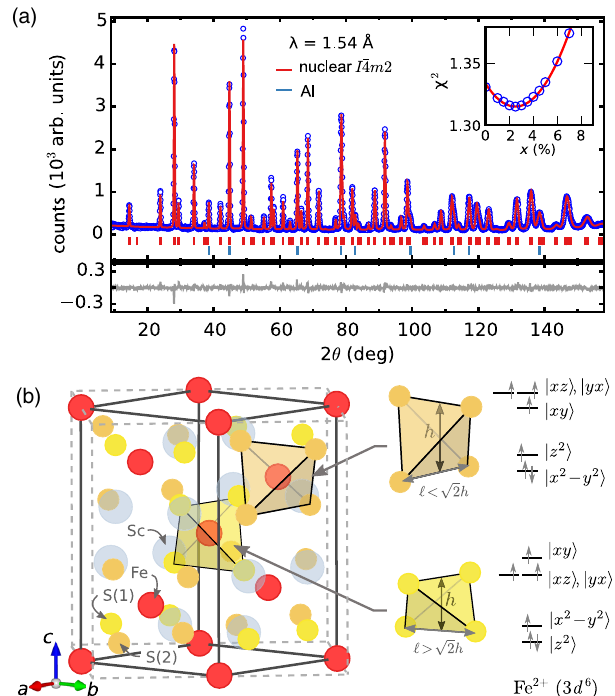
FIG. 4. (a) Neutron powder diffraction pattern for FeSc 2 S 4 measured on BT-1 at 20 K. Open symbols are observed intensities and solid red line is a Rietveld refinement of the nuclear structure ¯4 m 2 space group. Inset: Goodness-of-fit parameter to the I ( χ 2 ) versus the Fe-Sc antisite inversion. (b) Proposed I crystal structure of FeSc 2 S 4 . The refined lattice parameters are a ¼ 7 . 434 ð 1 Þ Å and c ¼ 10 . 493 ð 1 Þ Å. The parent cubic cell is shown as a light gray dashed outline. There are two crystallo- graphically distinct sulfur sites, labeled S(1) and S(2), resulting in two different Fe 2 þ coordinating tetrahedra alternately expanded and contracted along the tetragonal (001) direction. The corre- sponding Fe 2 þ ( 3 d 6 ) orbital states for small distortions of the S tetrahedra are shown on the right.